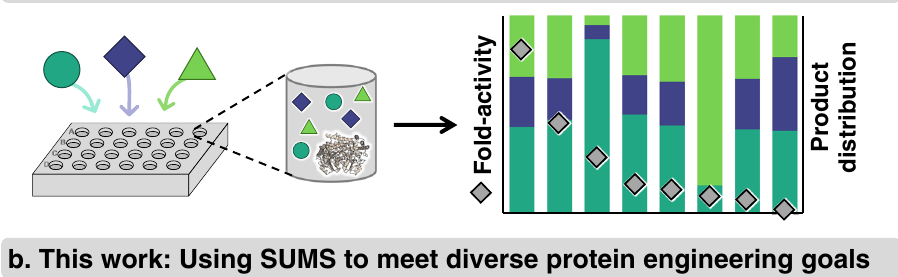
SUMS to a model biosynthetic cascade, forming tryptamines from indoles using Ruminococcusgnavus tryptophandecarboxylase( Rgn TDC)and Pyrococcusfuriosus tryptophan synthase β -subunit ( Pf